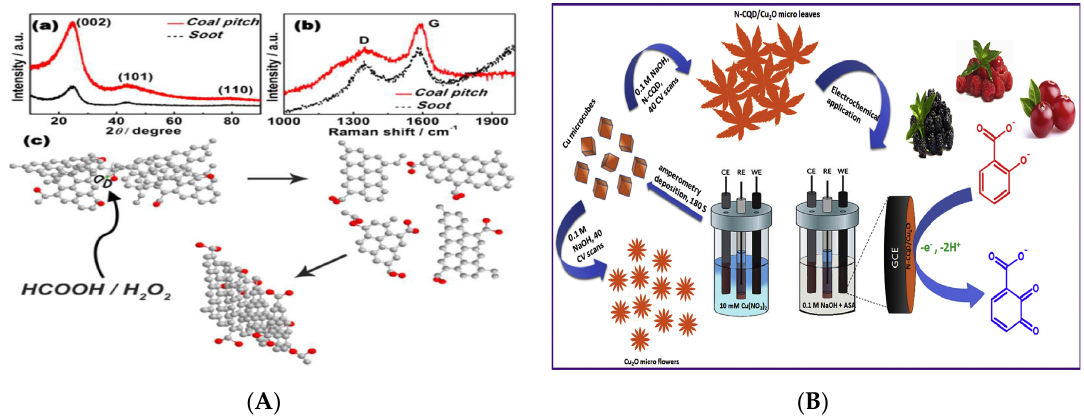
Figure 2. ( A ) Schematic of synthesis and characterization of CQDs by chemical oxidation (a: X-ray diffraction (XRD) patterns; b: Raman spectra; c: formation schematic of CQDs). Reproduced with permission from [48]. Copyright Chemical Communications, 2017; ( B ) Schematic of electrochemical preparation of N-CQDs / Cu 2 O and ASA detection in berries. Reproduced with permission from [54]. Copyright Journal of Colloid and Interface Science, 2018.